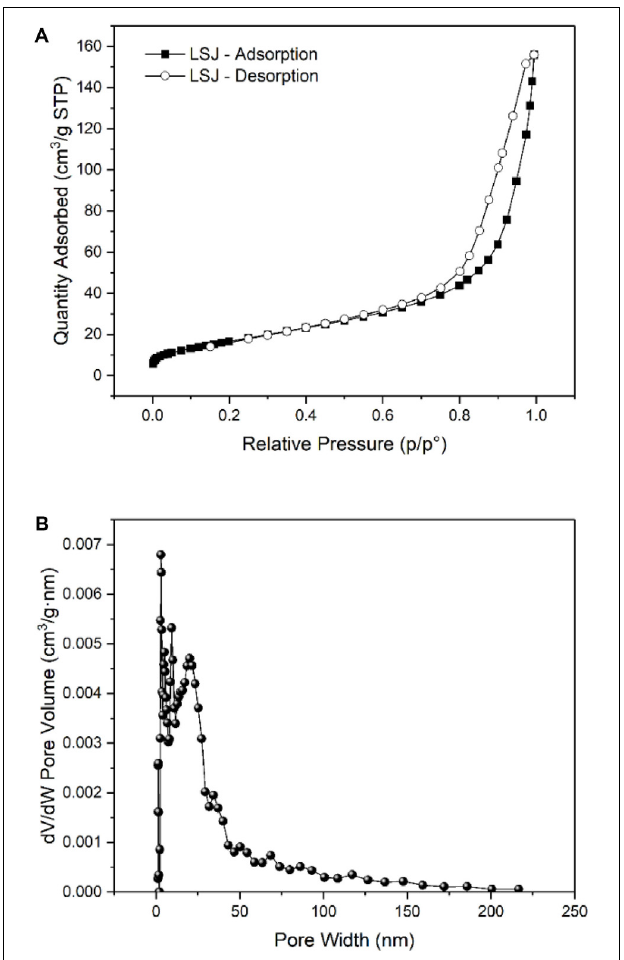
FIGURE 1 | (A) Nitrogen adsorption–desorption isotherms, and (B) pore size distribution of BC/MnO 2